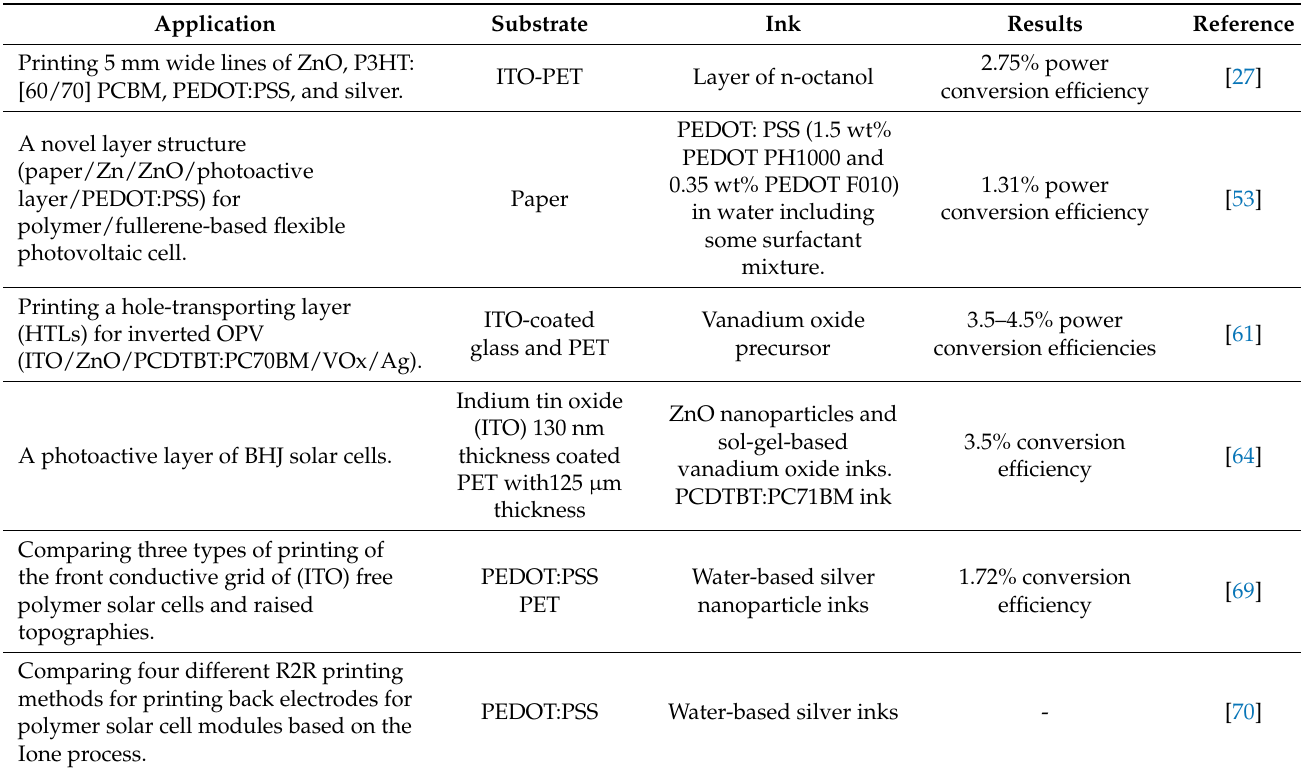
Table 2. Summary of flexographic printing technique on polymer solar